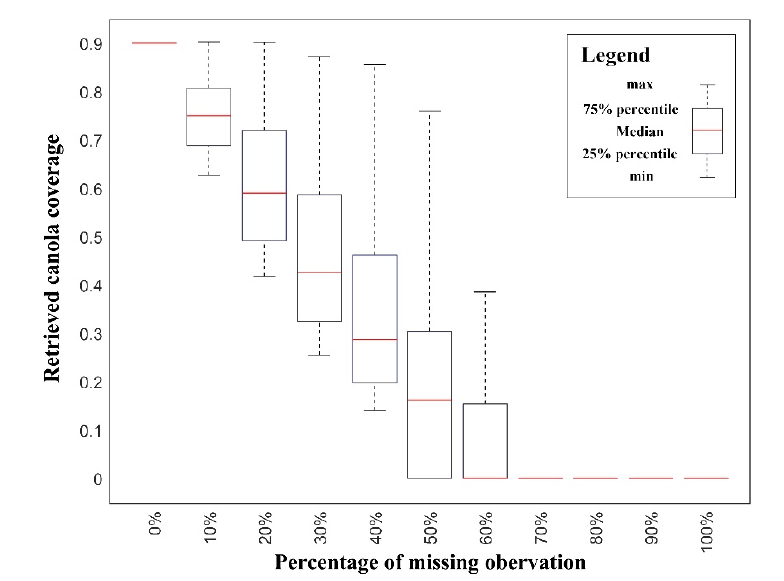
Figure 13. Impact of missing observations on the EAYI.